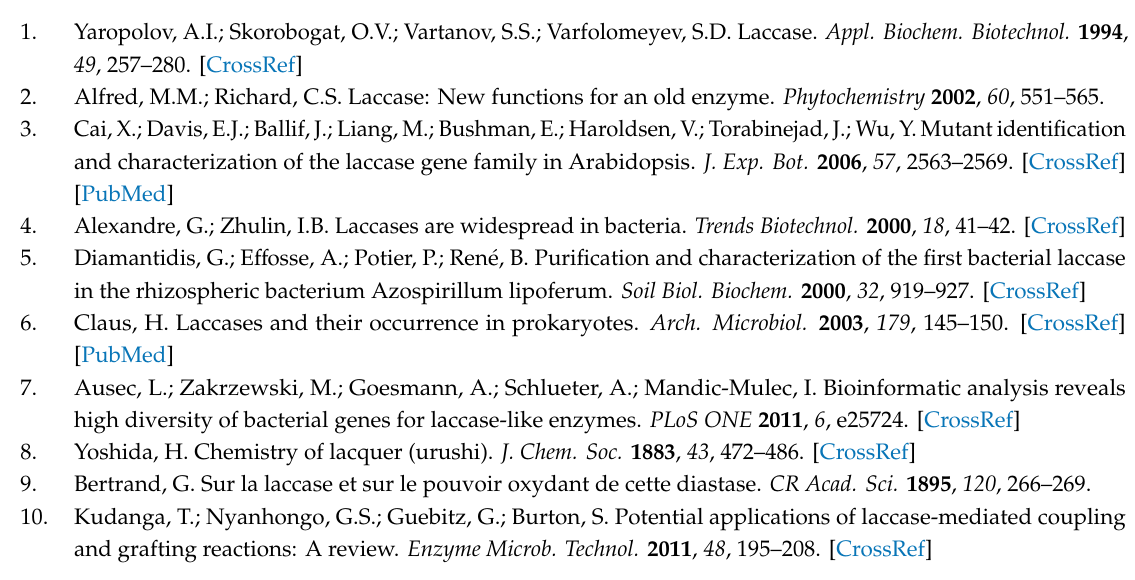
Table S1: Basic information of soybean laccases; Table S2a: Gene numbers in each phylogenetic class in soybean and Arabidopsis thaliana , Table S2b: Specific gene list of each phylogenetic class of Arabidopsis thaliana , Table S2c: Specific gene list of each phylogenetic class of soybean; Table S3: Collinear gene pairs and their Ka, Ks value and estimated divergence time; Table S4: List of tandem repeat and segmental repeat laccase genes; Table S5a: Expression pattern of soybean laccase gene family; Table S5b: Genes that are barely expressed in 9 detecteted materials; Table S6: Comparison of expression patterns between collinearity pairs; Table S7a: Soybean laccase gene expression pattern following P. sojae infection; Table S7b: Change value of laccase gene inoculation with P. sojae ( (cid:52) FPKM); Table S8: Primers used for qRT-PCR; Table S9a: Sliding window analysis of nucleotide diversity of 93 laccase gene sequence; Table S9b: List of selection GmLacs above average value; Table S9c: List of GmLacs experience sellection pressure above top 5% genome-wide level; Table S9d: Expression pattern of the 10 highly selected GmLacs ; Figure S1: Schematic diagram of the motifs of soybean laccase proteins; Data S1: SNPs (filtered) of all laccase gene of 302 soybean